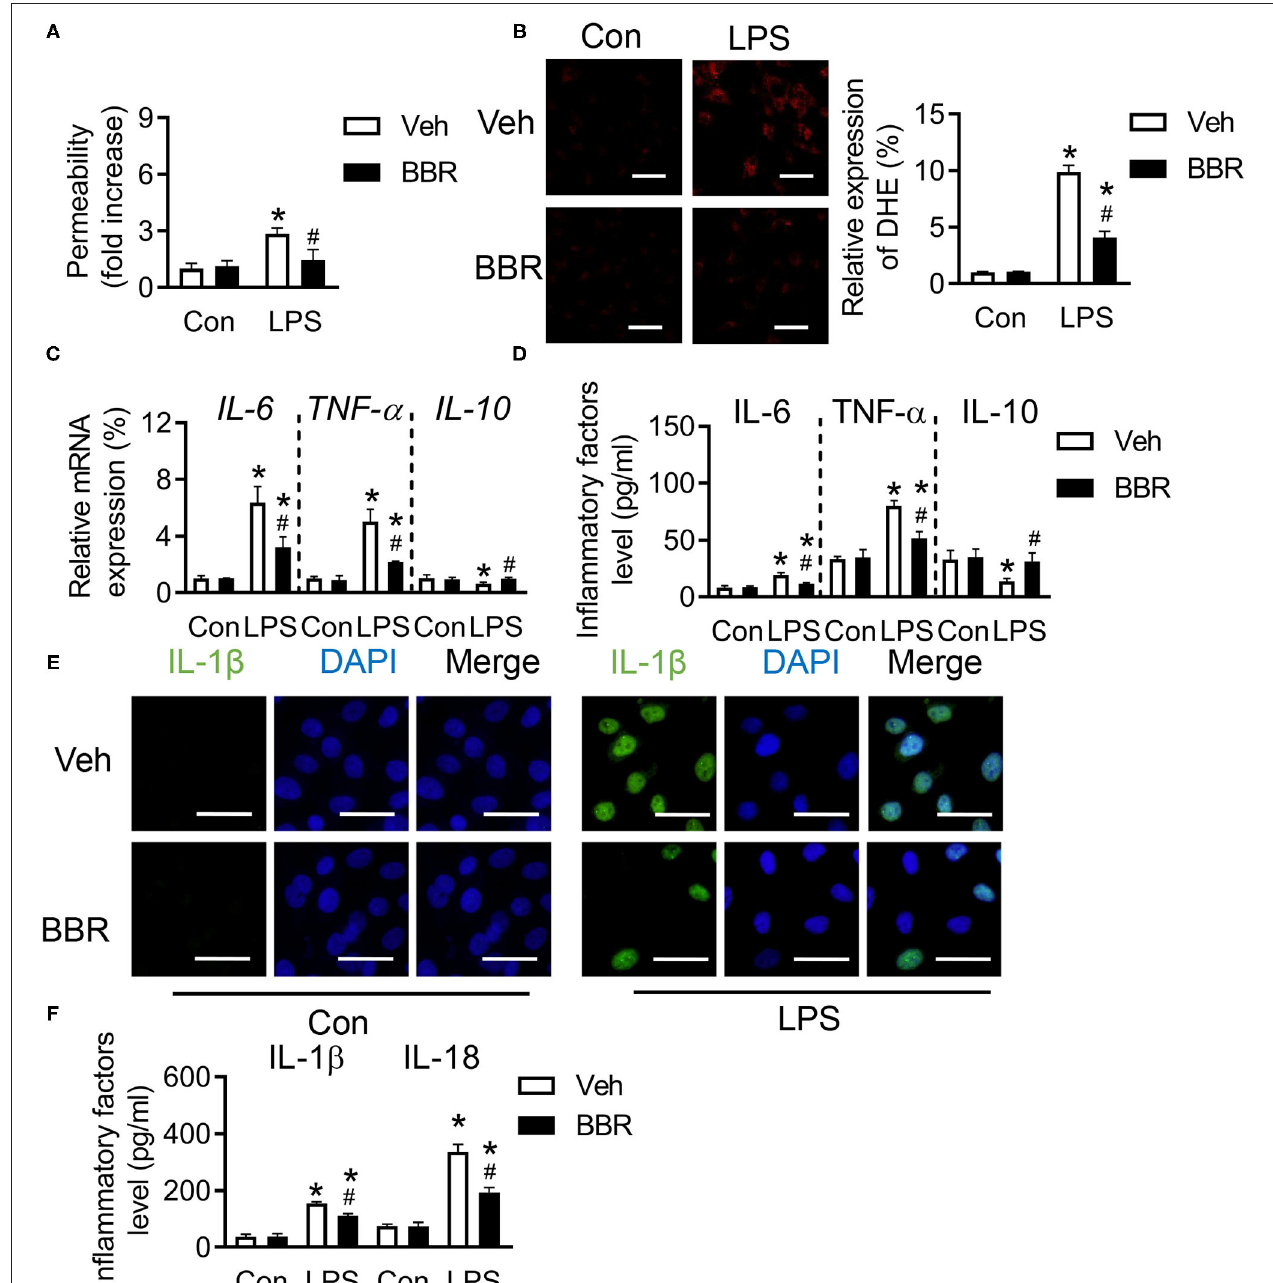
FIGURE 3 | Berberine inhibited the inflammatory cytokines in human pulmonary microvascular endothelial cells (HPMECs) induced with LPS. (A) The concentration of Evans blue in HPMECs, n = 8. (B) The expression of ROS in HPMECs and its quantification, n = 3, scale bar = 20 µ m. (C) The mRNA expression of IL-6 , TNF- α , and IL-10 in HPMECs, n = 3. (D) The concentration of IL-6, TNF- α , and IL-10 in HPMECs, n = 4. (E) The expression of IL-1 β in HPMECs, n = 3, bar = 50 µ m. (F) The concentration of IL-18 and IL-1 β in HPMECs, n = 4. Data were expressed as mean ± SD. Statistical significance is indicated as * P < 0.05 vs. the sham + vehicle groups, # P < 0.05 vs. the LPS + vehicle